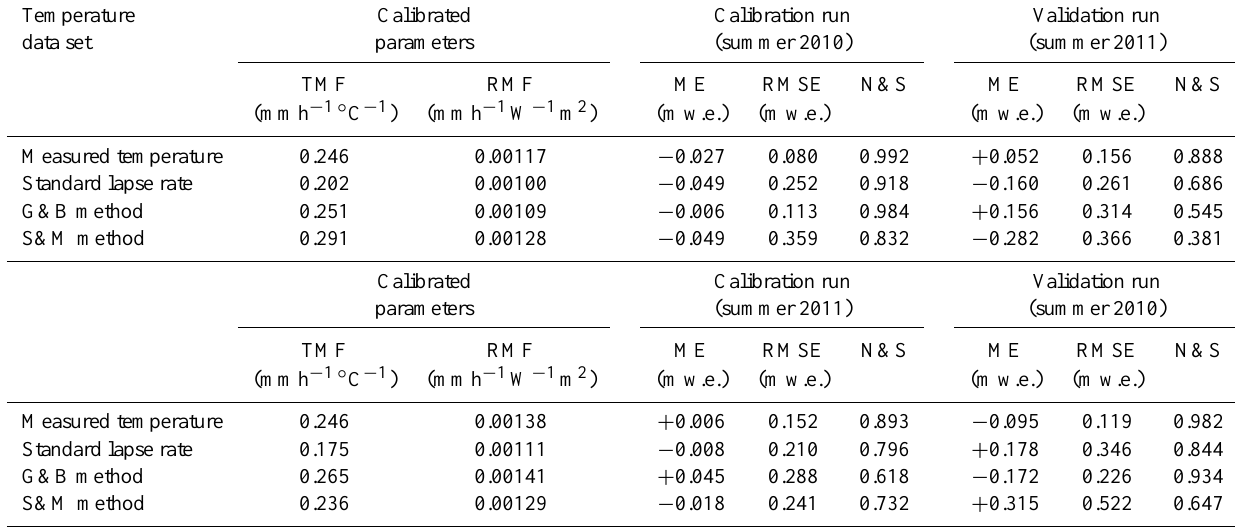
Table 5. Calibration parameters and mass balance statistics from EISModel applications with four different data sets of air temperature ∗